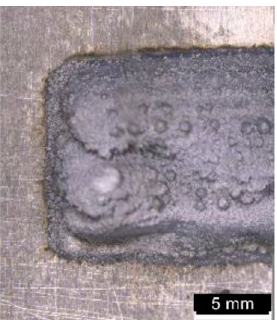
Figure 9 . Detail of surface irregularities of the first layer for 75% OR .